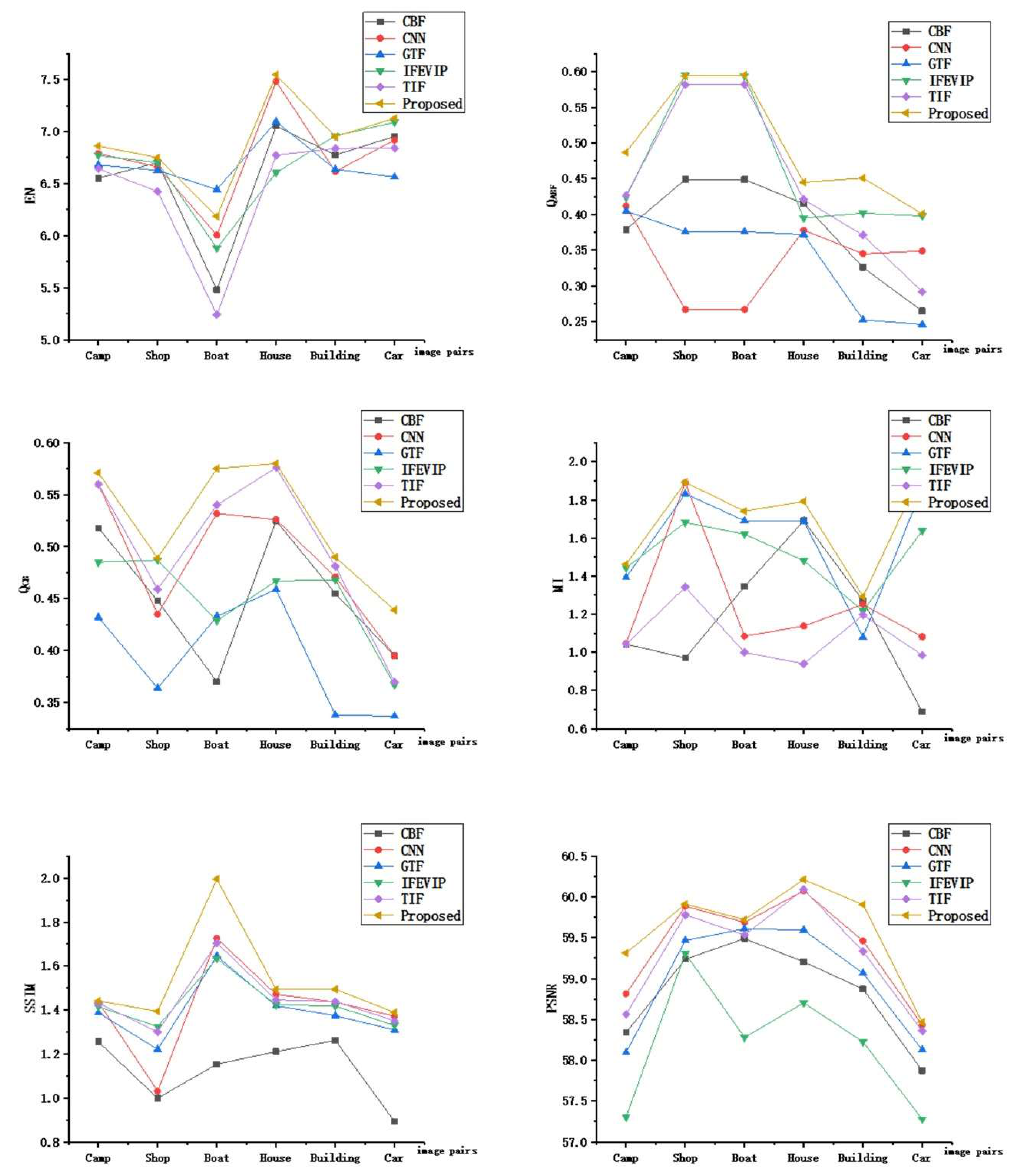
Figure 8. Objective evaluation metrics for fusion